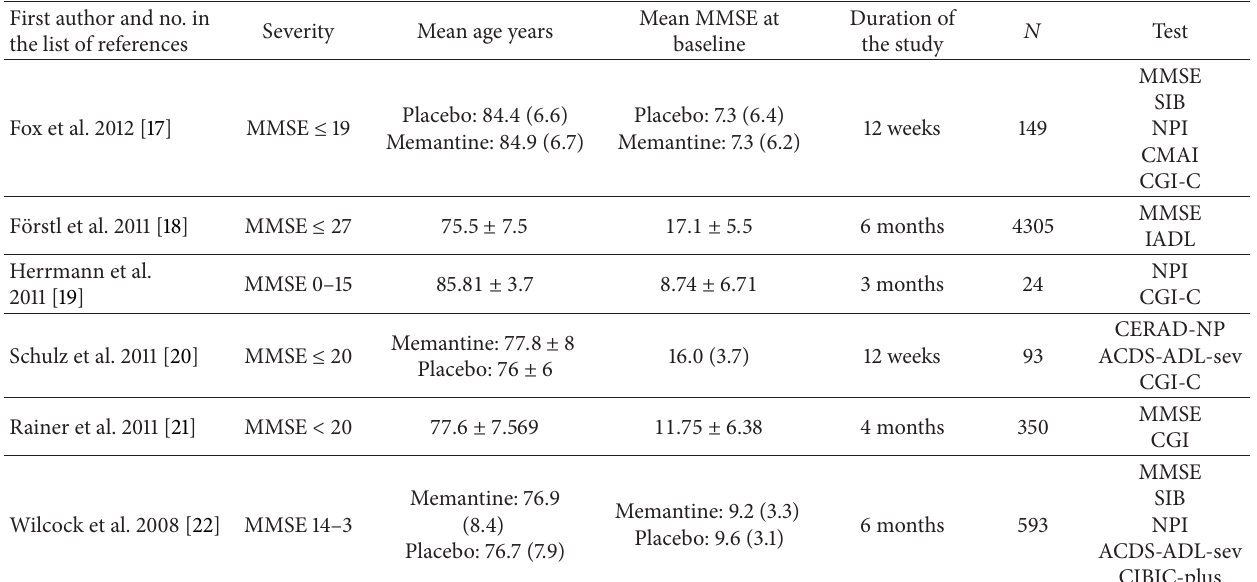
Table 3: Clinical trials examined assessing the influence of treatment with memantine in moderate-severe